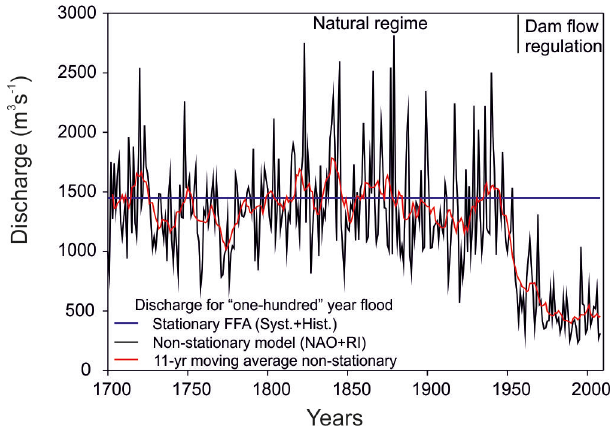
Figure 9. Non-stationary model of the “100-year” flood over the last 300 years based on the dependence of the distribution parame- ters with the associated external covariates (winter NAO index and reservoir index). The horizontal line represents the 100-year flood from a log-normal distribution using documentary and instrumen- tal records under a stationarity assumption (after Machado et al.,